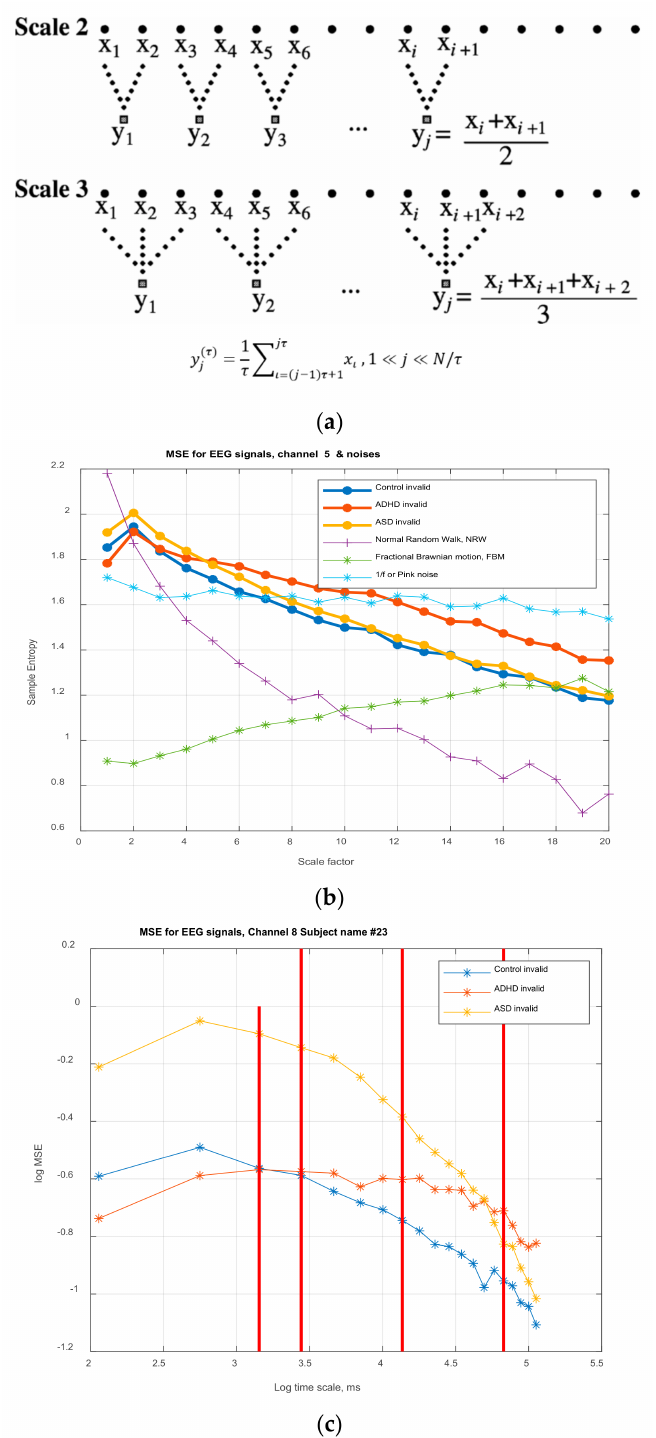
Figure 5. ( a ) The procedure for coarse-graining (Adapted from Costa et al. [47]). ( b ) Comparison of MSE curves (linear x y scales) for the three stochastic noises and three EEGs at channel 5 (indicative), for the invalid type of syllogism, and for the three groups of subjects (control, ASD, and ADHD). ( c ) MSE curves vs. time scales, in log–log scales, for subject #23 and channel 8, for invalid type of syllogism. The red line set the borders of frequency bands (gamma, beta, alpha, theta, and delta). (Taken from Papaioannou A. et al.